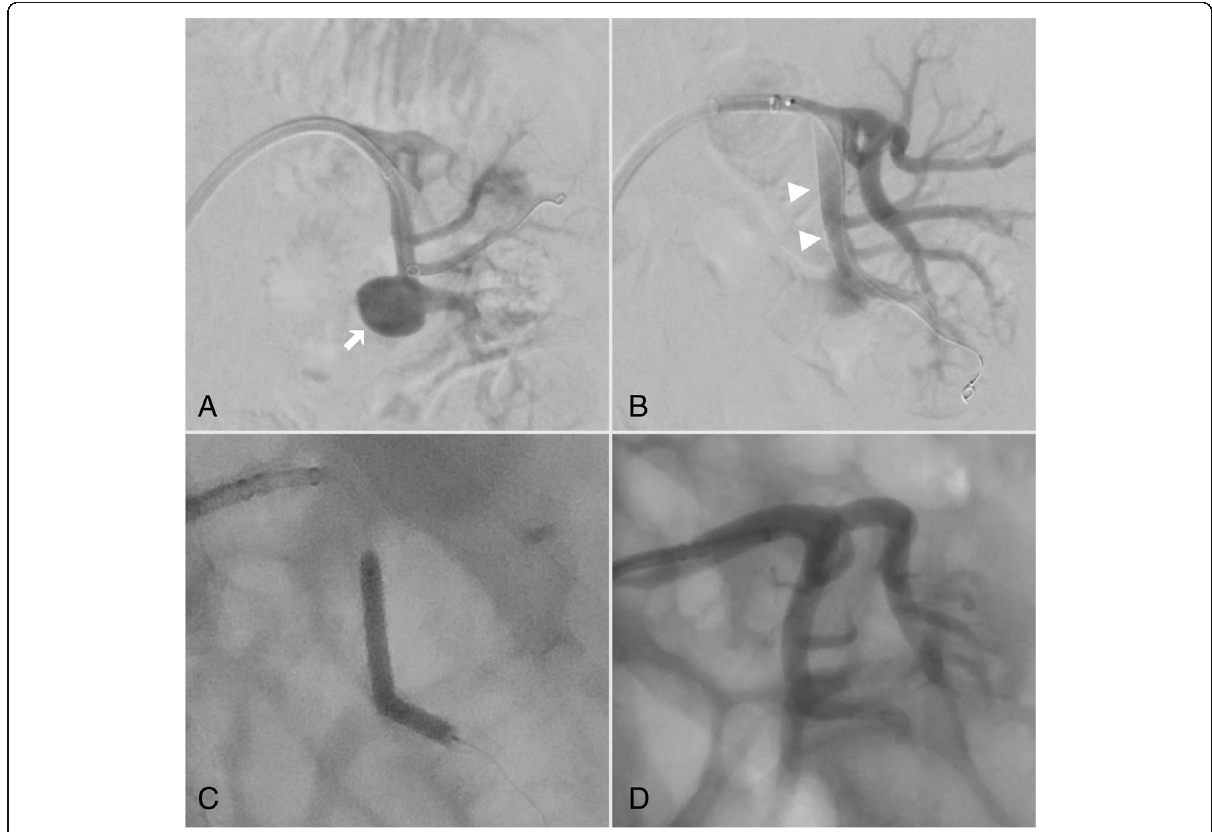
Fig. 3 DSA during treatment of a left anterior and inferior segmental renal artery aneurysm. a ) 1.9 cm wide necked segmental renal artery aneurysm (arrow) felt to be inappropriate for coil embolization. Note the 088 Neuronmax catheter. b ) Deployed Surpass Streamline flow diverter (arrowheads) with some expected residual aneurysm flow. c ) a 4 × 20 mm Armada balloon was used to improve stent apposition with the proximal and distal vessel wall landing zones and to ensure exclusion of the aneurysm neck given the origin of the aneurysm from an outer convexity. d ) post treatment angiogram with minimal aneurysm flow and preserved end organ